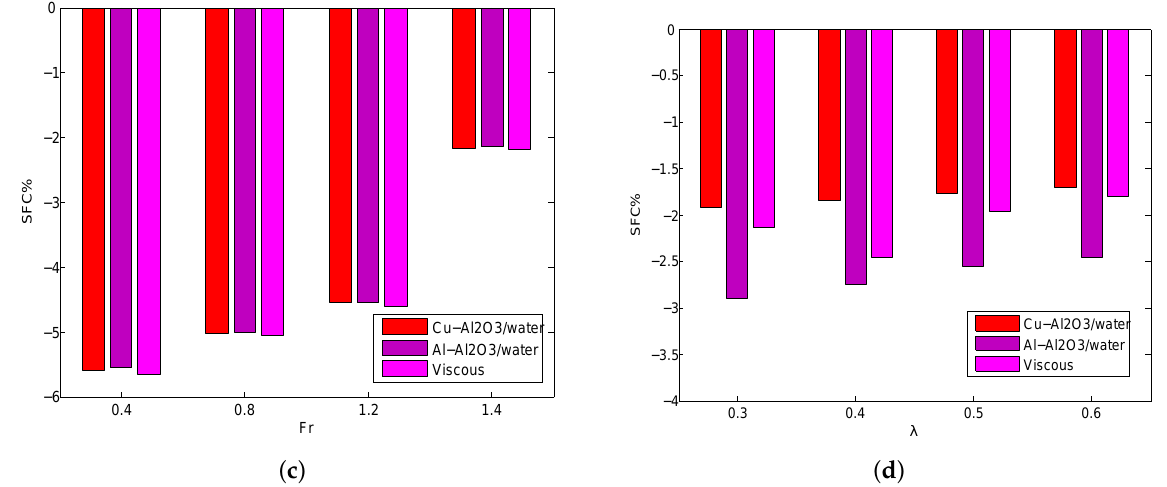
Figure 6. The destructing percentage of SFC for various values of M ( a ), fw ( b ), Fr ( c ), λ ( d ) for both HNFs.